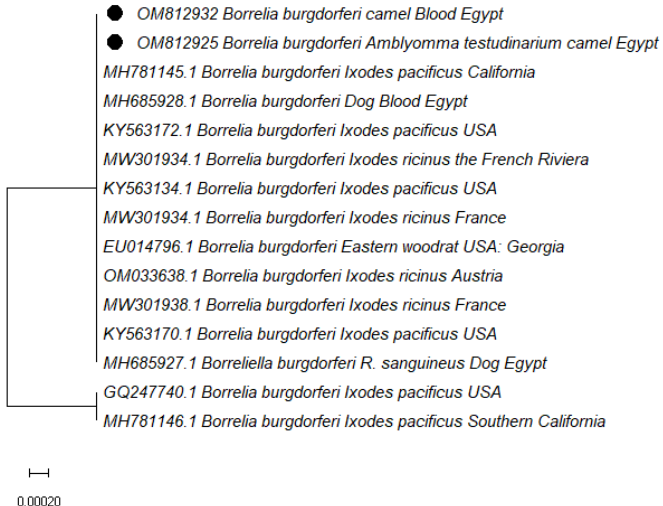
Figure 4. Phylogenetic relationships based on the 16S rRNA gene sequences of B. burgdorferi. The trees were constructed and analyzed using the Maximum Likelihood method. The accession numbers with black dots are from this study.